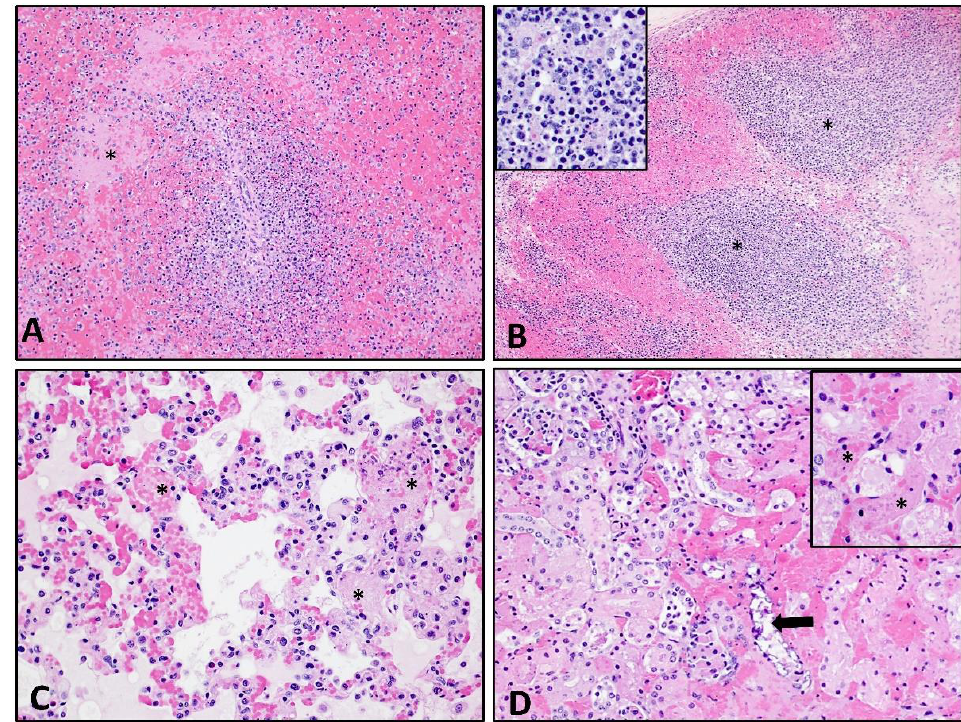
Figure 7. Histological lesions following ASFV-MNG19 infection. ( A ) Spleen: Marked lympholysis and collapse of periarterial sheaths and fibrin thrombi (asterisk) in marginal zone (100×). ( B ) Renal lymph node: Marked lympholysis and necrosis (asterisk and insert) with loss of cortical and sinusoidal lymphocytes accompanied by marked filling and expansion of the subcapsular and medullary sinuses with hemorrhage and fibrin (100× and 400× insert). ( C ) Lung: Marked expansion of the alveolar spaces by congestion, fibrin thrombi (asterisk) and necrotic cellular debris, eosinophilic proteinaceous material; edema, fibrin and occasional macrophages fill the alveolar spaces (200×). ( D ) Kidney: Multifocal congestion and fibrin thrombosis (insert-asterisk) of the interstitial capillaries accompanied by hemorrhage and coagulative necrosis and dystrophic mineralization (arrow) of tubules (200×, 400×-insert).